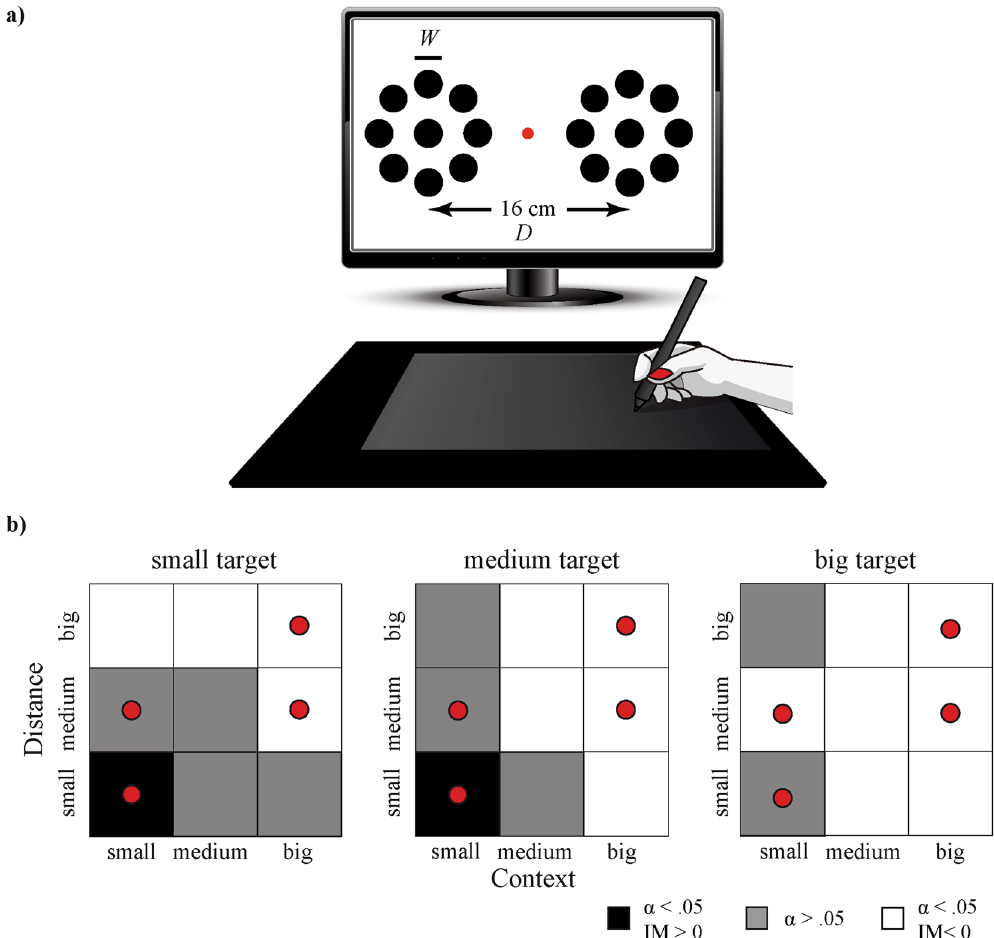
Figure 7. ( a ) Experimental set-up of the horizontal sliding task, with W representing the target size and D the distance between the targets on the left and right side. ( b ) Selected parameter combinations adopted from ref. 27 are marked with a red dot for each quantified target size, context size, and target—context distance. The black and white squares indicate a significant illusion magnitude (IM) for bigger perceived targets and smaller perceived targets, respectively. The grey squares show conditions that were not significantly different from the control trials ( α = 0.05; see ref. 27 for